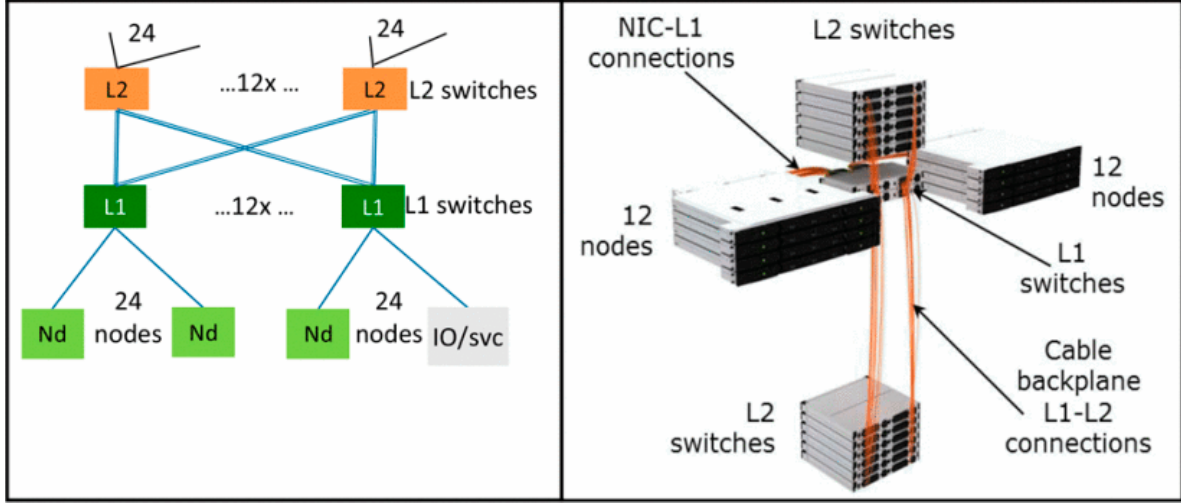
Figure 8. Bull exascale platform network logical configuration and physical layout [15].